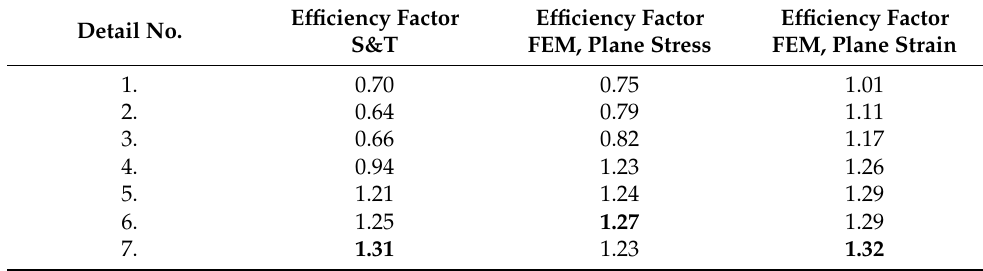
Table 7. Efficiency factors for all reinforcement details obtained using all methods (maximal values in bold). Detail